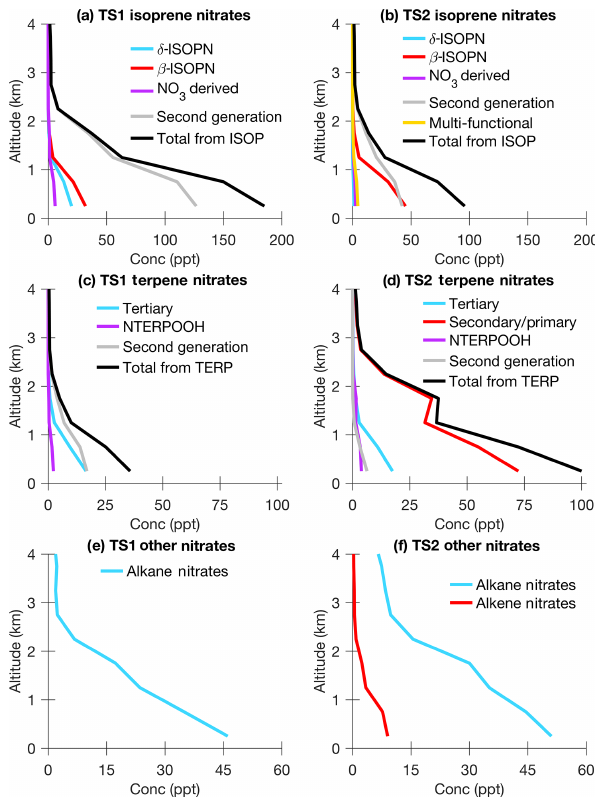
Figure 10. Median vertical profile plots over the SEAC 4 RS flight tracks for all isoprene, terpene, and other nitrates formed in the TS1 and TS2 mechanisms binned as specified in Fig. 9. For iso- prene, ISOPN includes all isoprene hydroxy nitrates; NO 3 derived includes all nitrates derived only from NO 3 -initiated oxidation (i.e., ISOPNOOH, INHE, and NC4CHO; Fig. S1); second generation in- cludes all second-generation nitrates; and multi-functional includes all multi-functional later-generation nitrates. For terpenes, tertiary includes all tertiary hydroxy nitrates; secondary/primary includes all secondary/primary hydroxy nitrates; NTERPOOH includes all tertiary hydroperoxy nitrates; and second generation includes all second-generation nitrates, which for TS2 includes only the multi- functional low-volatility organic nitrates (Sect. 4.2). All dinitrates are